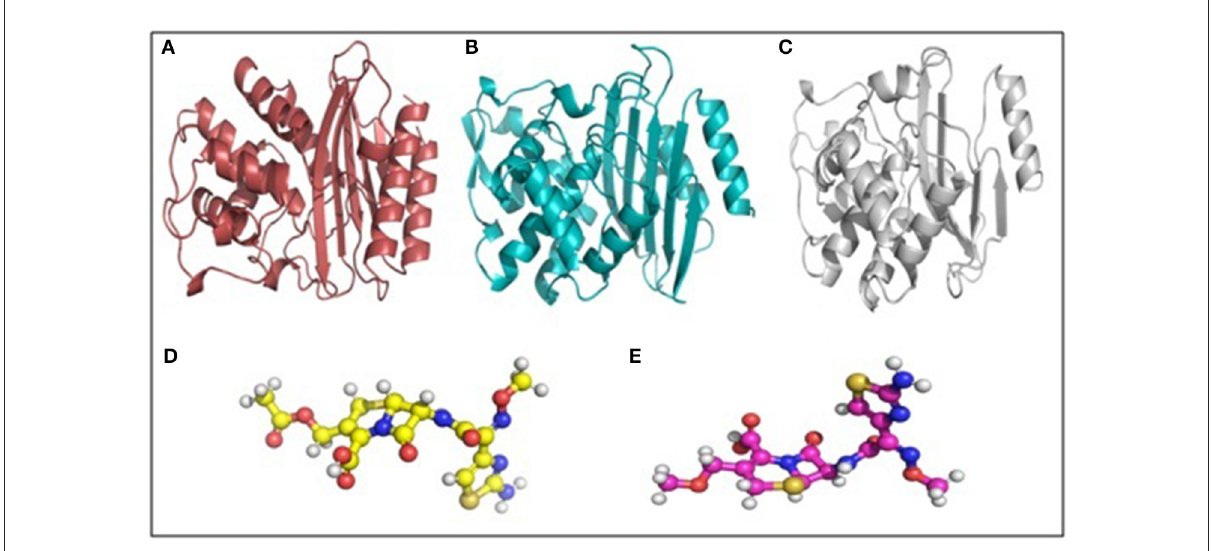
FIGURE5 Macromolecule and ligand representation (3D) in PyMOL. These color codes have been mentioned throughout the study. (A) Cartoon representation of TEM-1 in ruby color. (B) Cartoon representation of CTX-M-15 in cyan color. (C) Cartoon representation of SHV in gray color. (D) Ball and stick representation of cefotaxime (ligand bonds are in golden color). (E) Ball and stick representation of cefpodoxime (ligand bonds are in lilac